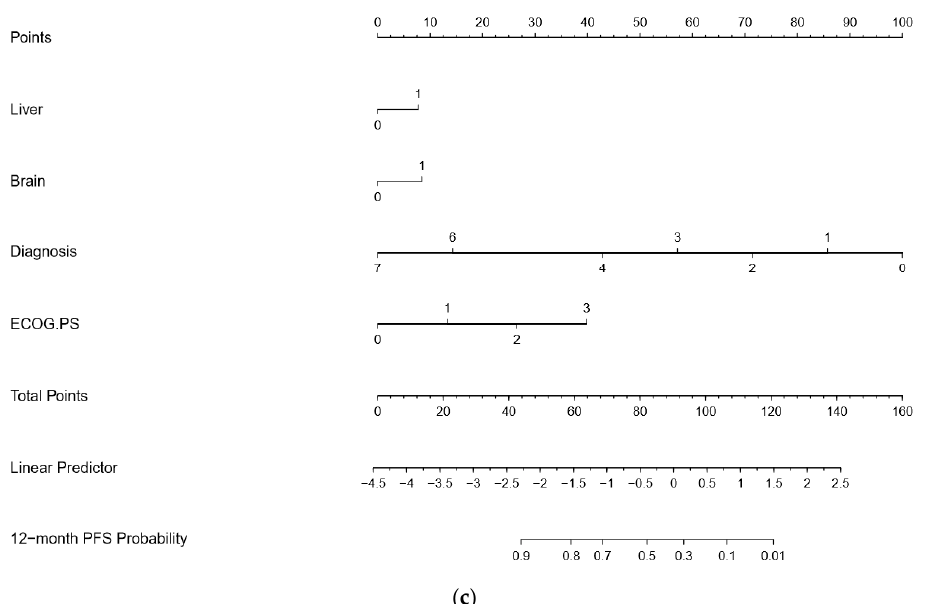
Figure 2. ( a ) 12-month OS nomogram; ( b ) 24-month OS nomogram; ( c ) 12-month PFS nomogram.